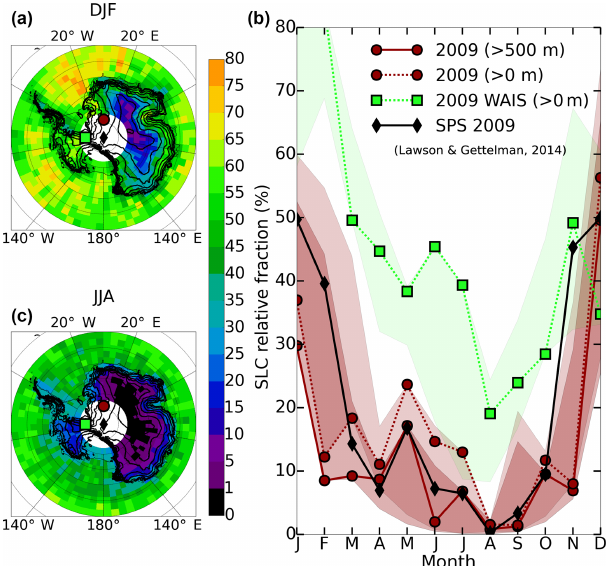
Figure 13. (a, c) Geographical distribution of the 2007–2010 av- erage of the SLC relative fraction in DJF (a) and JJA (c) . The di- amond marker indicates the Amundsen–Scott South Pole Station (SPS). The circle and square markers indicate the approximate lo- cations of the grid boxes – north of the markers – used to extract the time series in area 1 (circle) and area 2 (square), respectively (see text for exact definition of area 1 and 2). (b) column: Monthly time series of the DARDAR SLC relative fraction in 2009 with (solid red line) and without (dotted red line) the lower altitude cut-off of 500m, extracted north of the circle marker shown in (a) and (c) . The dotted green line shows the time series extracted north of the square marker shown in (a) and (c) . The shaded areas represent the corresponding interannual variabilities. The black diamond markers show the relative fraction of mixed-phase clouds observed with the MPL at SPS (2850ma.s.l.) in 2009 (Lawson and Gettelman, 2014, extracted from their Fig.